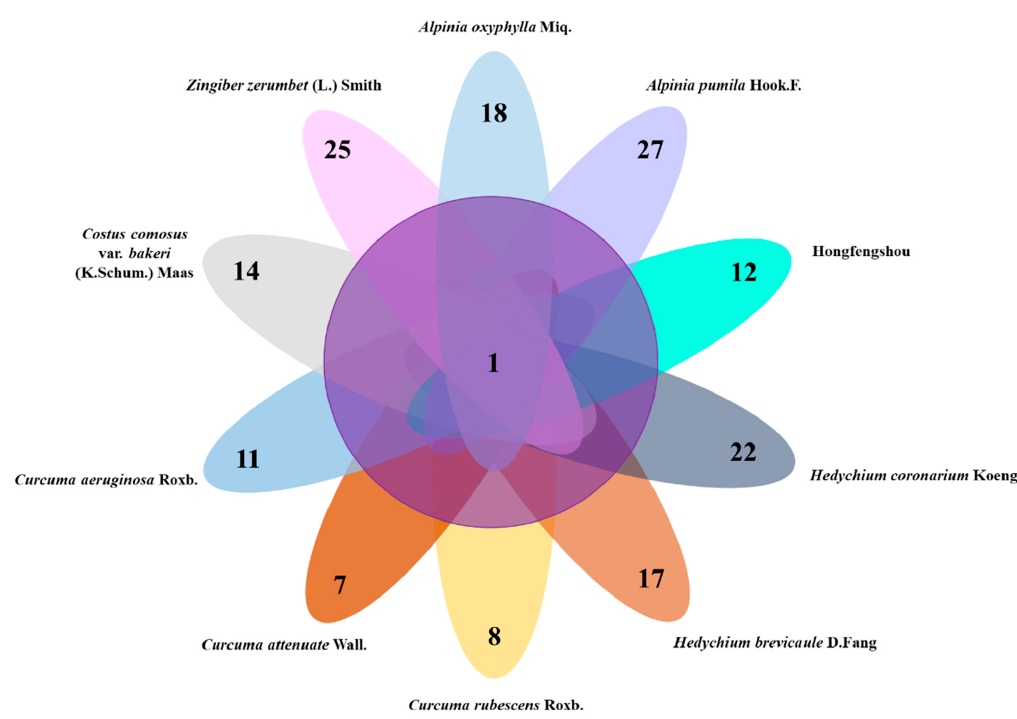
Figure 4. Venn diagram of ten species of Zingiberaceae. The number in the middle represents the number of common volatiles across various Zingiberaceae plants, and the numbers in each circle represents the number of unique volatiles in each Zingiberaceae plant.